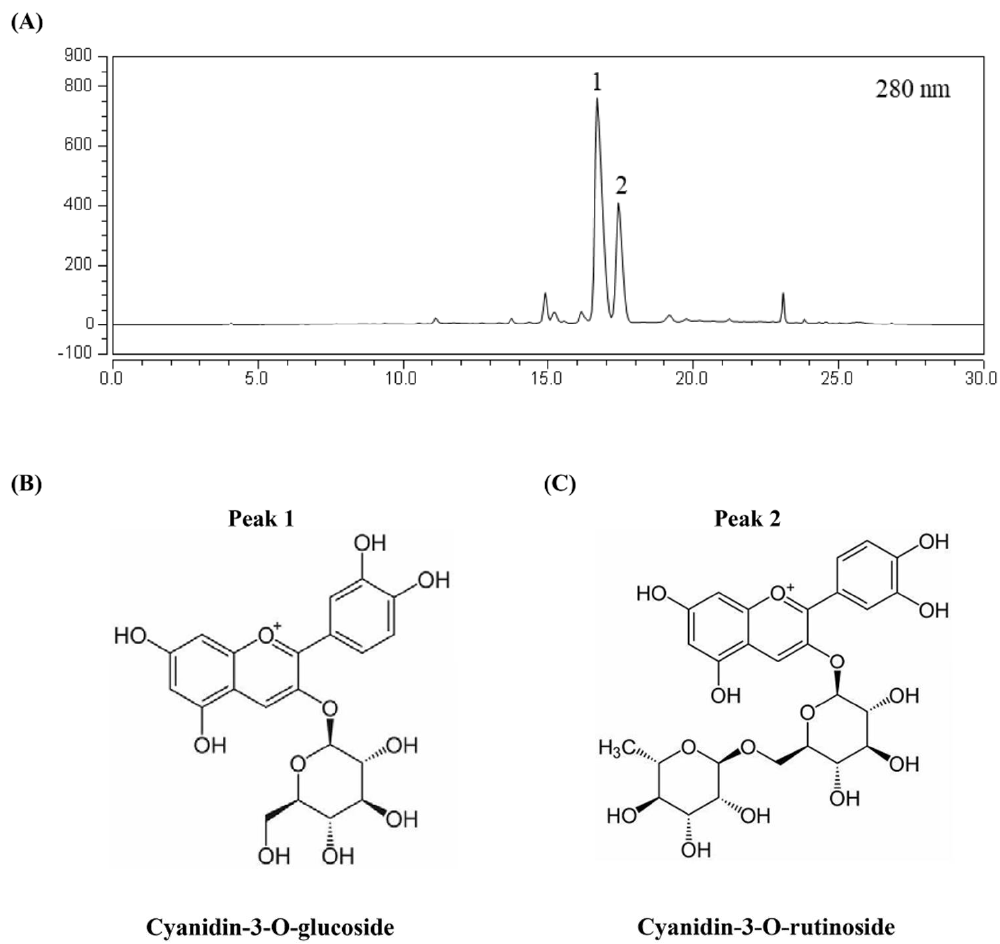
Figure 1. HPLC chromatograms of MAS. ( A ) The absorbance was detected at 280 nm. ( B ) Compound name and structure in peak 1. ( C ) Compound name and structure in peak 2.